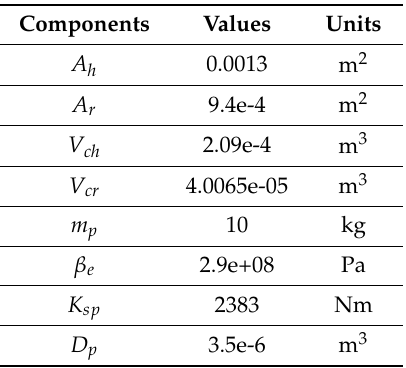
Table 1. Basic parameters of the mini motion package (MMP) system. Components Values